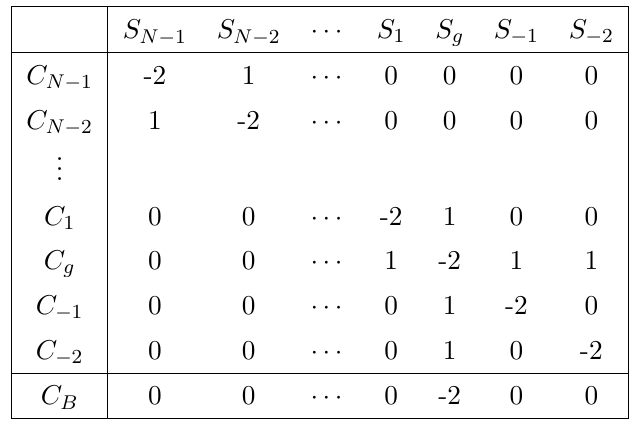
2 ; 1 ; g; 1 ; ; N 1 and the (cid:0) (cid:0) (cid:1) (cid:1) (cid:1) (cid:0)